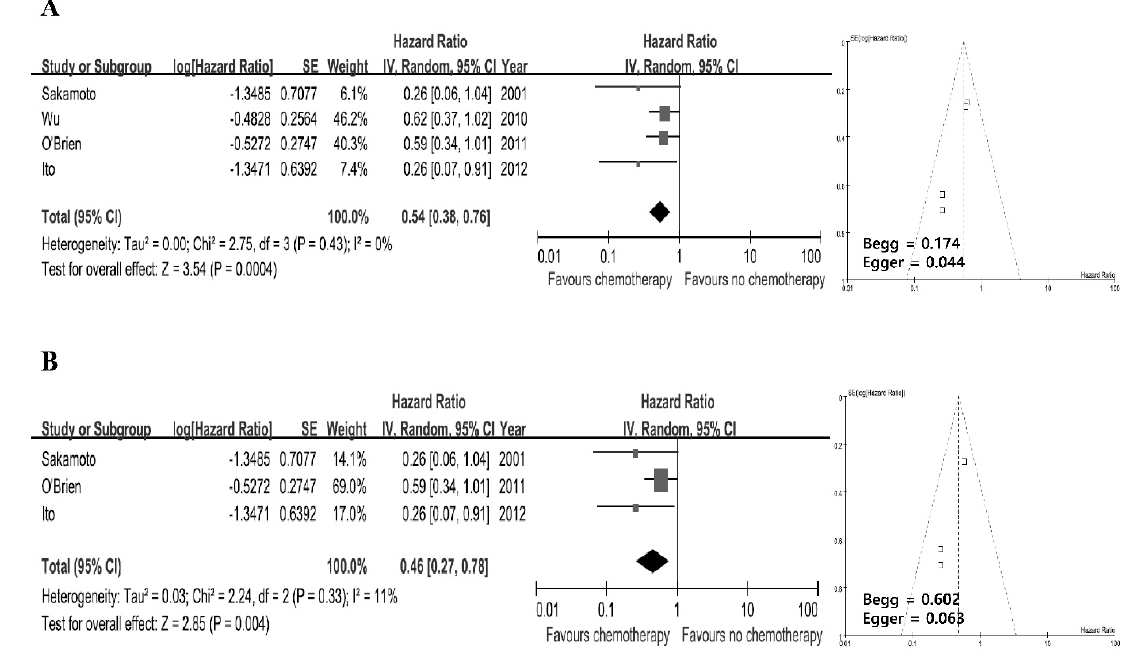
Figure 4. Forest plots (Left). Horizontal lines correspond to study-specific hazard ration and 95% CI. The area of the square reflects study-specific weight. The diamond represents pooled results of hazard ratio and 95% CI. Begg funnel plots for publication bias test are shown (Right). Each point represents a separate study for the indicated association. Vertical line represents mean effects size. ( A ) All studies; ( B ) Prospective controlled studies.